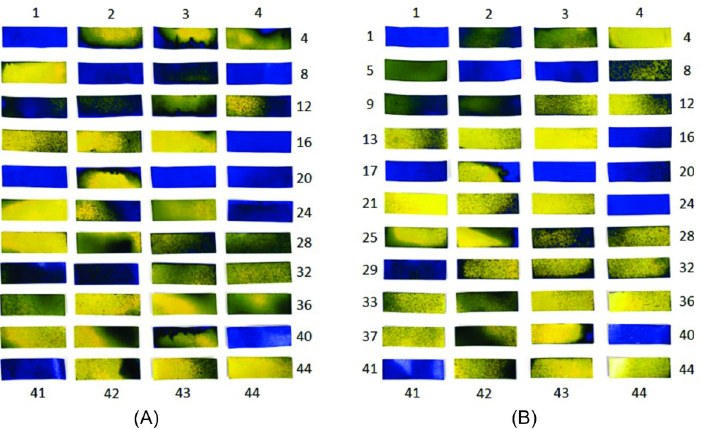
Fig 18. WSPs applied to different regions of the body of an individual properly dressed with PPE and exposed to the biocidal agent during passage through the disinfection chamber with six nozzles in 30 s. (A) Sample 1; (B) Sample